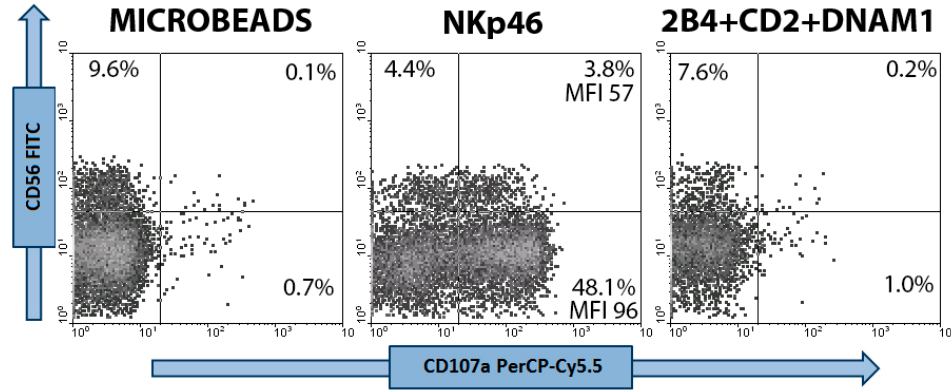
Figure 1. Flow cytometric dot plot analyses of peripheral blood NK cells. Three day IL-2 (1 ng/mL) stimulated NK cells were selected within the lymphocyte scatter region and then gated on the basis of CD56+/CD3- phenotype. NK cell samples were stimulated for 2 h with mAb unloaded microbeads (negative control), or microbeads loaded with anti-NKp46 or with anti-2B4 plus –CD2 and –DNAM-1 mAbs. CD56 dim and CD56 bright NK populations are distinguished based on CD56 intensity of expression. NK cell degranulation is detected by measuring surface expression of CD107a. Relative percentages of degranulating (CD107a+) NK cells and CD107a MFI are shown.